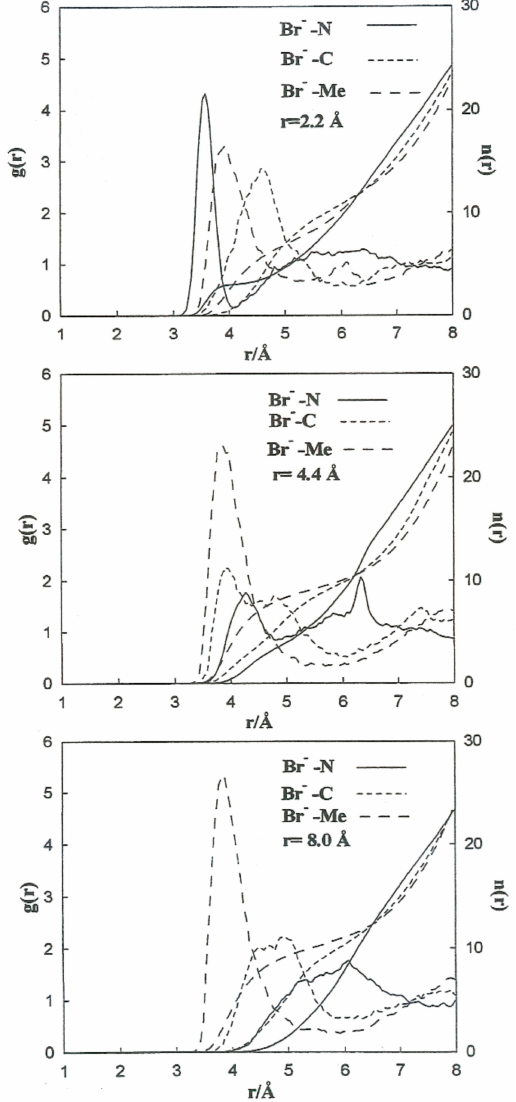
Figure 9. Radial distribution functions and running coordination numbers for Br − at several interi- onic separations for the Li + -Br − ion